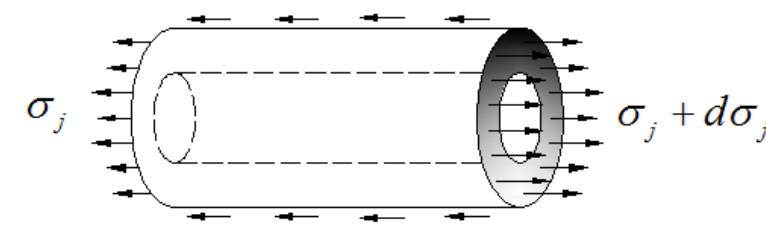
Figure 3. Mechanical model of interlayer micro unit.